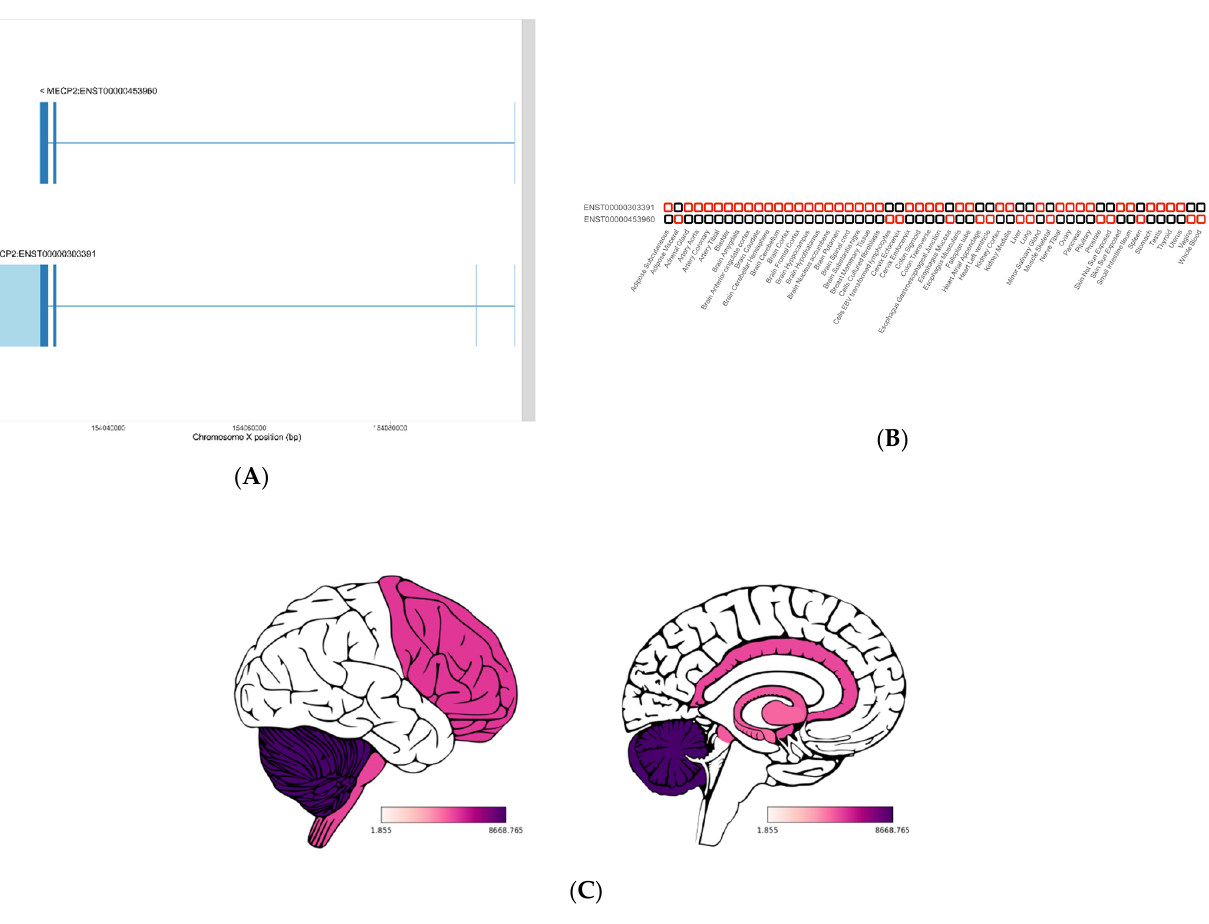
Figure 6. MECP2 transcript depiction: ( A ) MECP2 schematic diagram of the two major isoforms. ( B ) Transcript switch between the different MECP2 isoforms. ( C ) MECP2 gene expression in different brain areas. In A, UTR sequences are represented in light blue. In total, 14 rank 1 transcript switches are detected among the 54 tissues studied in the TREGT database. The GTEx brain expression profile (TPMs) is represented in C using the cerebroViz R package; cerebroViz output for exterior (left) and sagittal (right) views.